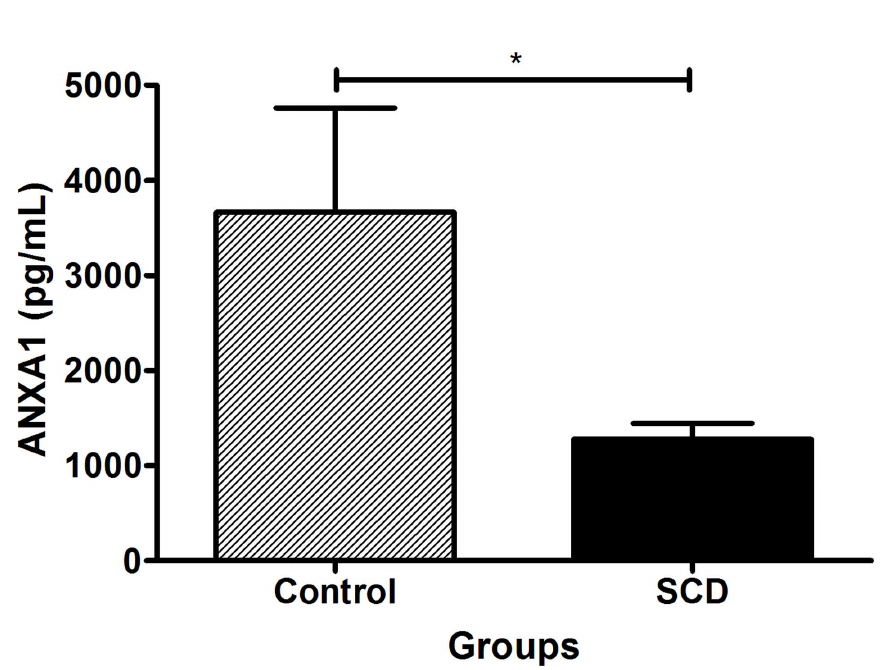
Fig 2. Plasma levels of ANXA1 in control and SCD groups. Data expressed in mean ± standard error of the mean. Statistical analysis: Student’s t-test . * p < 0.05.